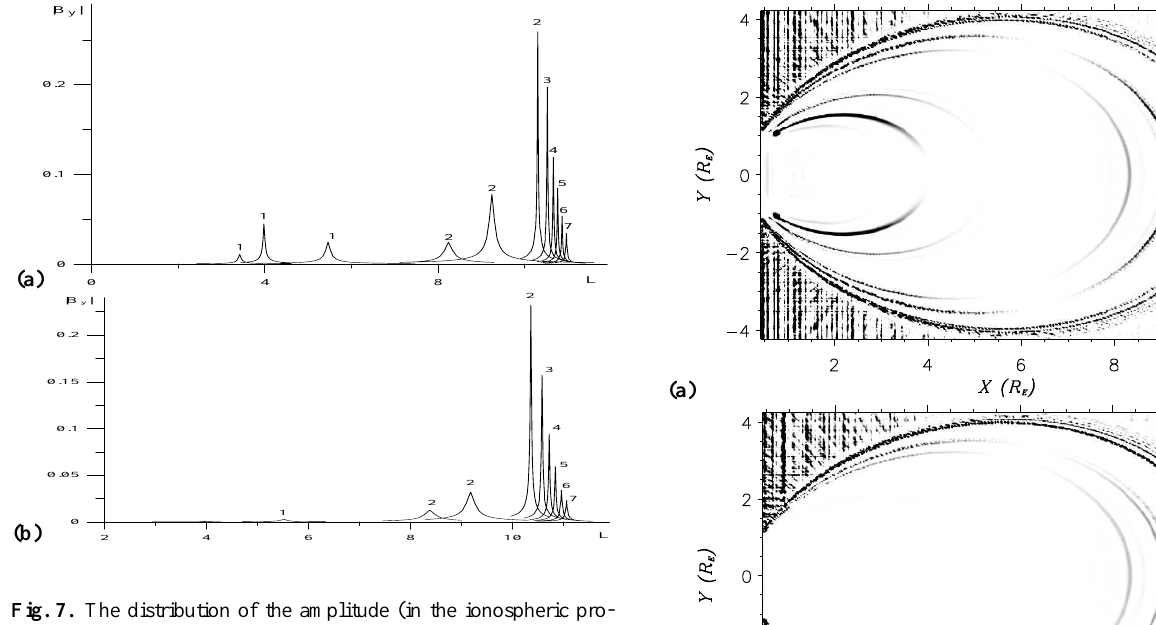
Fig. 7. The distribution of the amplitude (in the ionospheric pro- jection) of the total field of resonant oscillations excited by the monochromatic FMS wave (by the model driver (19)) in the dipole magnetosphere. Panel (a) shows the field of oscillations excited by the FMS harmonic n = 1 , m = 1 with a frequency of 0.01Hz; Panel (b) presents the field of oscillations excited by the harmonic n = 5 , m = 3 with the same frequency.